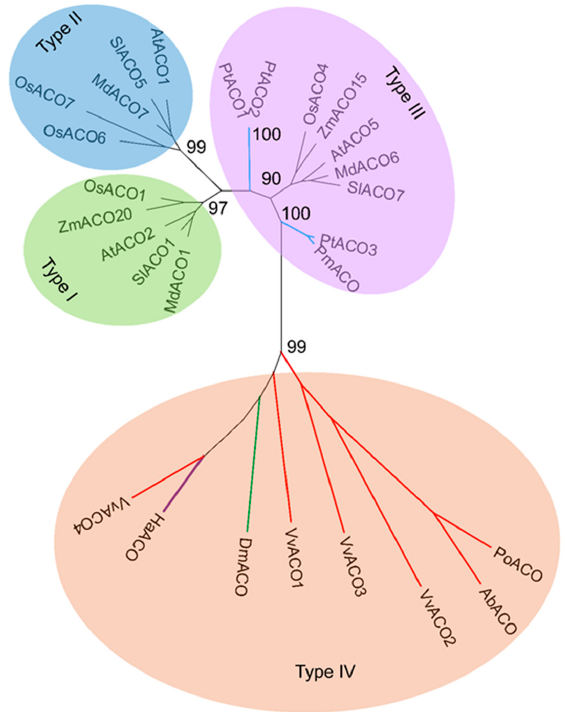
Figure 3. Selected functional ACO protein sequence alignment of mushrooms, slime molds and plants. Protein sequences were aligned using ClustalX 2.0. The important and conserved amino acid residues were marked in accordance with the legend shown.